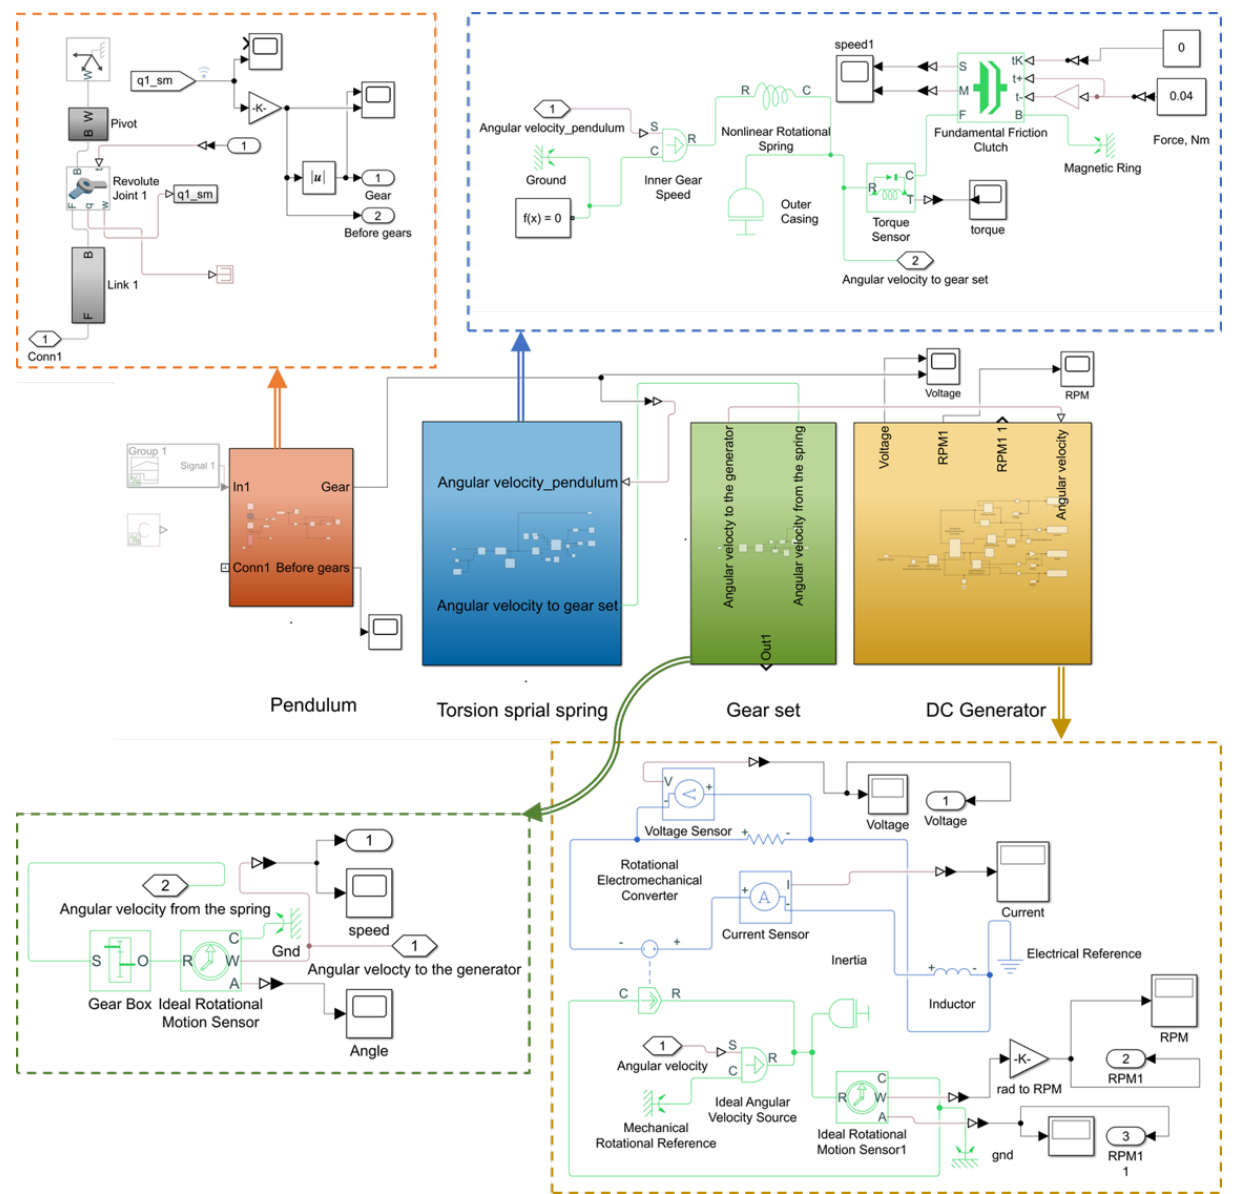
Figure 4. Developed Matlab/Simulink model of the kinetic energy